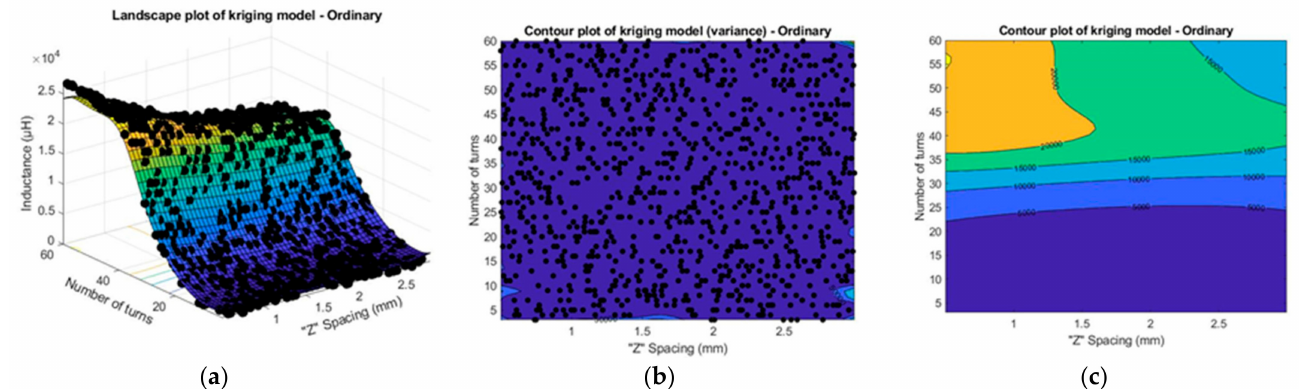
Figure 8. ( a ) The Ordinary Kriging response surface, ( b ) the variance plot and, ( c ) the contour plot of the inductance.